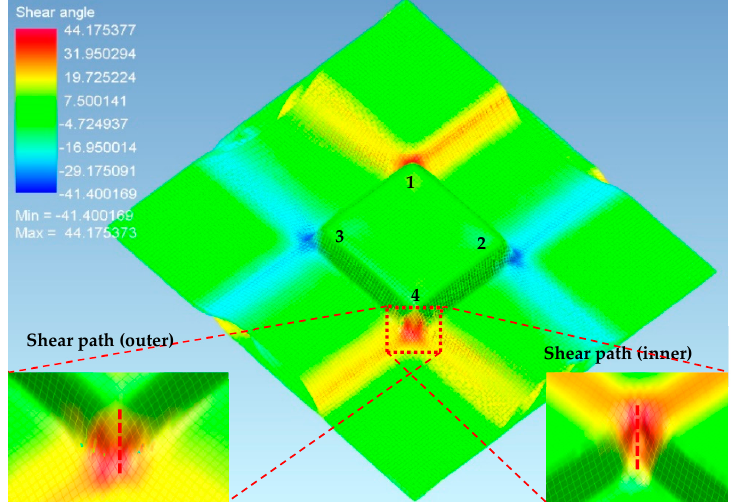
Figure 10. Predicted shear angles in the Type 1 mold design with the pattern 1 prepreg laminate at ( a ) corner 1; ( b ) corner 2; ( c ) corner 3; ( d ) Corner 4 using the PAM-FORM simulation (From top view).